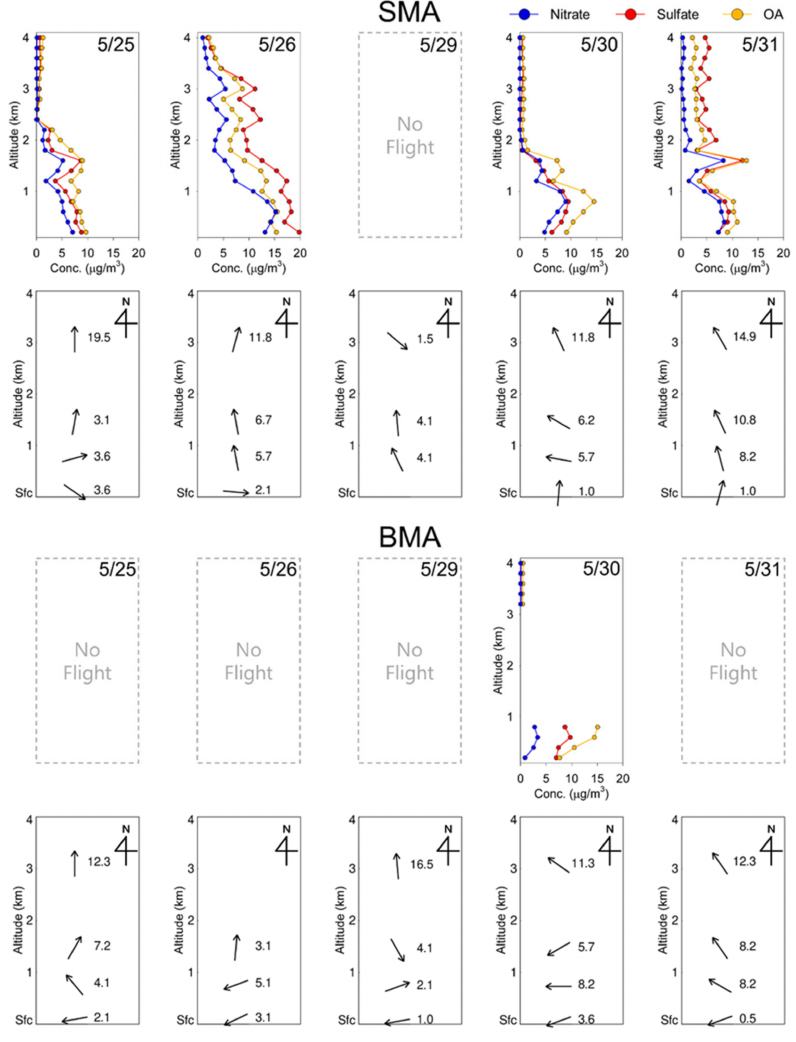
Figure 7. Same results as those shown in Figure 6, but for the long-range transport period (25–31 May). The two synoptic cases showed differences in their vertical distributions by wind speed and direction. In the STG case, the changes in nitrate and sulfate concentrations were small, whereas the change in OA was significant. In addition, little change in vertical concentrations was found with altitude. These results were mainly driven by the high tem- perature and generally low wind speed of the STG case, which supported the accumulation of OA. In the LRT case, in contrast, the nitrate, sulfate, and OA concentrations decreased more sharply with altitude. The main difference between the LRT and STG cases is that high-concentration peaks at high altitudes appeared only in the LRT case at around 1–3 km. These LRT features indicate the inflow of pollutants at specific altitudes, and broader distributions at higher altitudes. Overall, the concentration of OAs was exceptionally high in the upper layer, without secondary peaks, in the case of STG, whereas the nitrate and sulfate concentrations were high in the LRT case. This difference is presumably due to the difference in atmospheric chemical and physical environments inside and outside of the receptor areas affecting SIA or SOA generation mechanisms in source areas, or during the LRT process [34,35]. This finding highlights the importance of investigating the